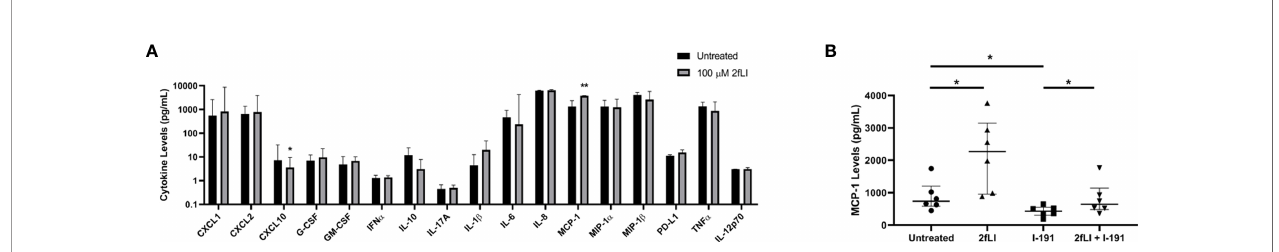
FIGURE 9 | PAR2 modulates MCP-1 expression from PsA monocytes/macrophages. The expression of 20 chemokines/cytokines measured from conditioned medium of blood-derived PAR2-expressing monocytes/macrophages of PsA patients (n=8) using a multiplex Luminex assay is shown in (A) . Cells were cultured for 48 h in the presence or absence of 100 µM 2fLI and stimulated with LPS during the last 4 h. The expression of IFN g , IL-17E and IL-4 were below the limits of detection and are not shown. Values are graphed on a log 10 scale to better visualize differences between groups. MCP-1 was also measured in additional samples of blood-derived PAR2-expressing monocytes/macrophages (n=6) in the presence of 30 µM I-191, 100 µM 2fLI or both (B) . Expression was compared between groups using the Wilcoxon matched-pairs signed rank test. Error bars indicate the median ± interquartile range. Asterisks are used to indicate signi fi cant differences between groups, where *p < 0.05 and **p